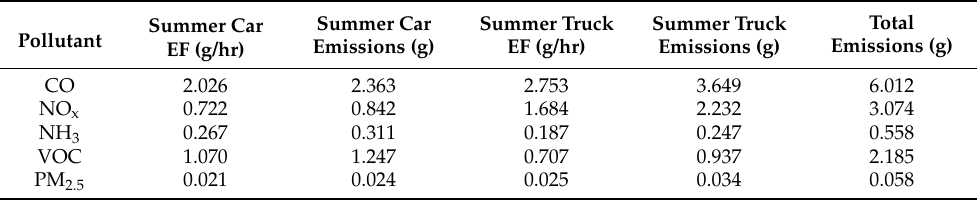
Table 13. Summer emission factors (EF) and potentially avoided emissions due to observed idling